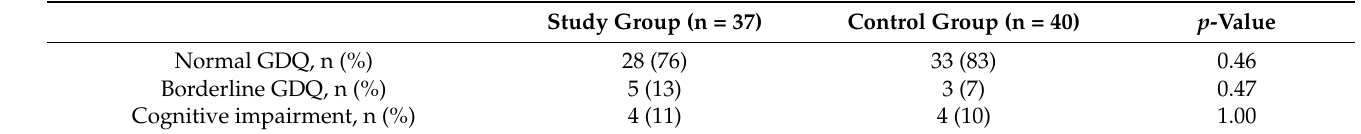
Table 5. Distribution of Griffith’s Developmental Quotient (GDQ) in the two groups at 24 months CA.